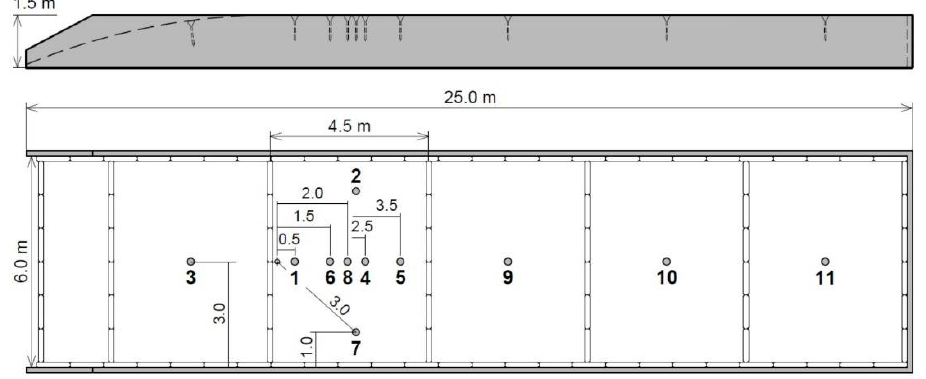
Figure 2. Test setup in large-scale silo. Numbers show the sensor nodes, (1–4 = iteration 1, 4–11 = iteration 2). Letters show two different sites of implemented air breaches.